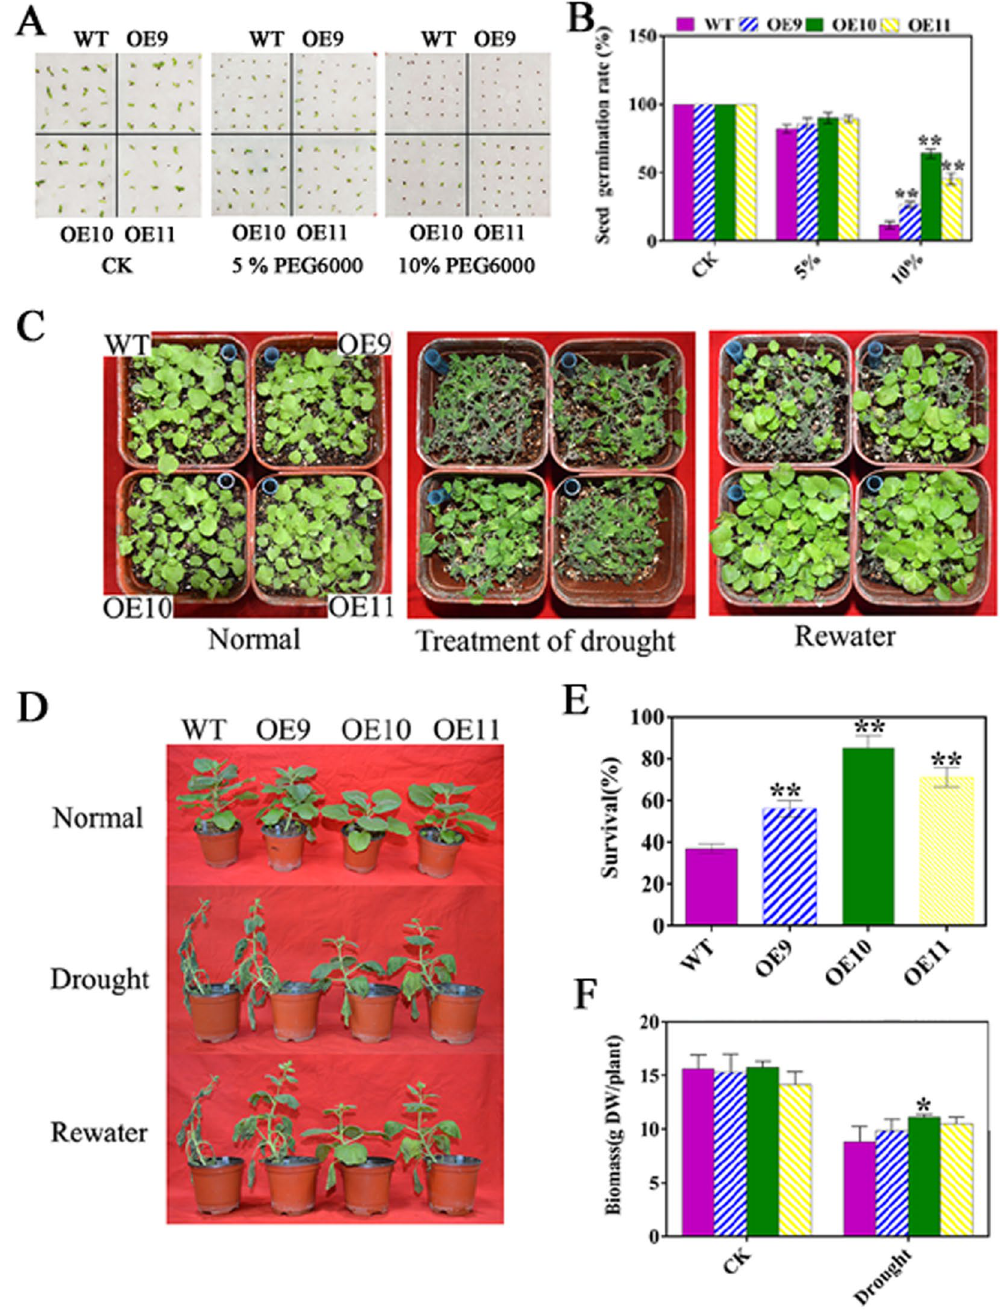
Figure 2. Influence of drought stress on the growth of TaPUB1 -overexpressing and WT plants. ( A ) Phenotype of seedlings grown on MS medium containing different concentrations of PEG6000 for 7 d. ( B ) Comparison of the germination rates of TaPUB1 -overexpressing and WT plants. Values are means ± SEs of at least three independent experiments (n = 45 seeds per treatment). ( C ) The phenotypes of 2-week-old TaPUB1 - overexpressing and WT plants subjected to drought treatment for 5 d and to subsequent re-watering for 2 d. ( D ) The survival ratio was calculated as the percentage of plants that resumed growth 2 d after re-watering. ( E ) Phenotypes of OE and WT plants exposed to water withholding treatment at the 2-month-old stage. Representative plants subjected to drought stress for 5 d. After 5 d of drought treatment, the plants were rewatered and their recovery was recorded. ( F ) The biomass of TaPUB1 -overexpressing and WT plants. The experiments were repeated three times and the bars indicate SEs. * and ** indicate significant differences at P < 0.05 and P < 0.01 in the values among the three overexpression lines and the WT